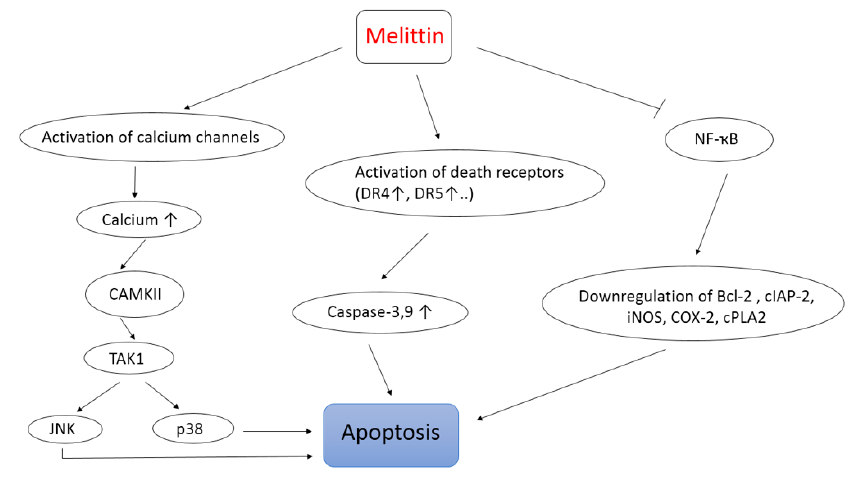
Figure 3. Schematic drawing of main mechanisms of action of melittin as an anti-cancer agent.